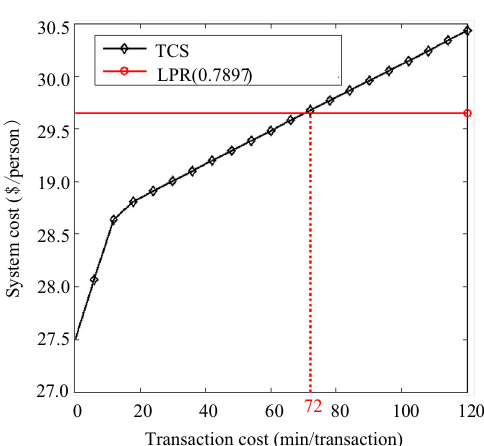
Fig. 7 T C for different q ( k =